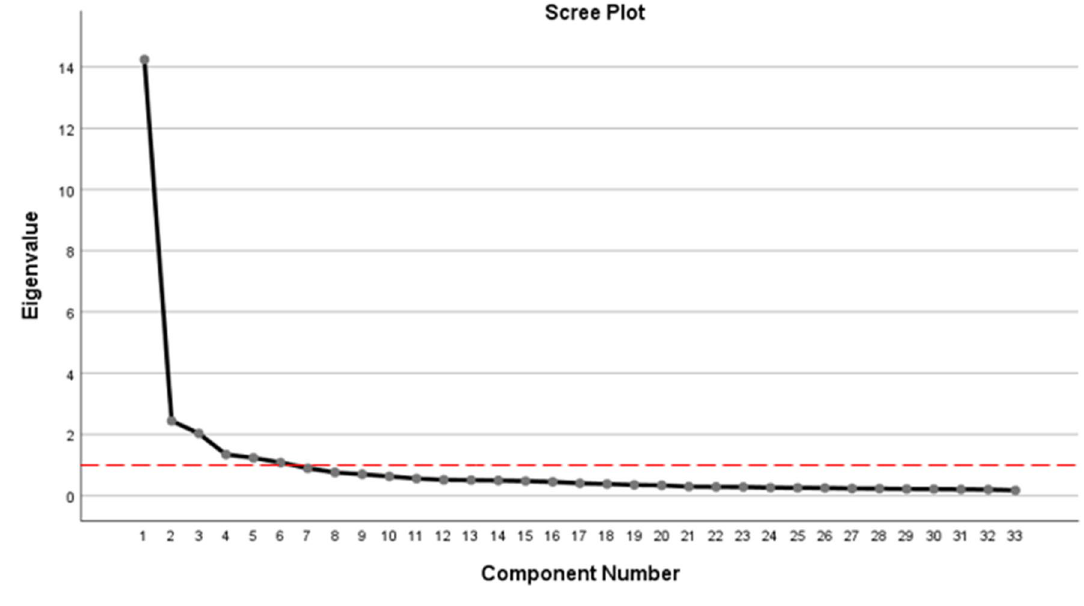
Figure 1. Component number.